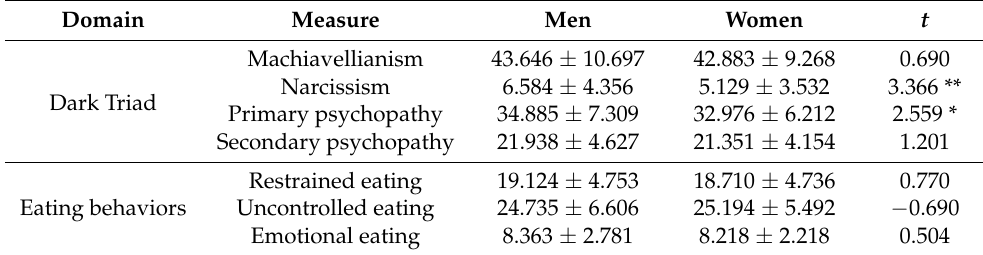
Table 1. Means and standard deviations by sex for all variables.